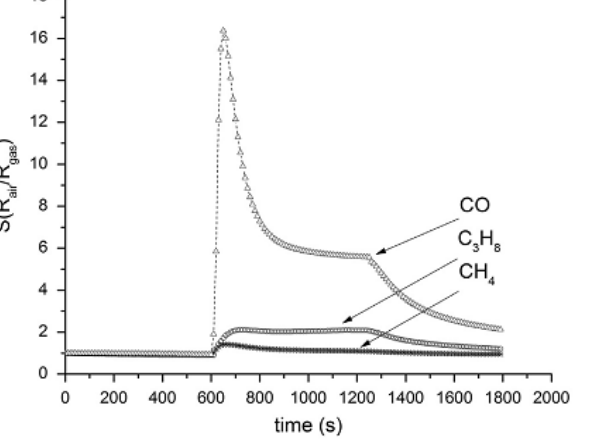
Figure 16. 50% SnO 2 -50% ZnO sensor response for 50 ppm CO, CH 4 , and C 3 H 8 at T w = 500 °C, from ref. [69].